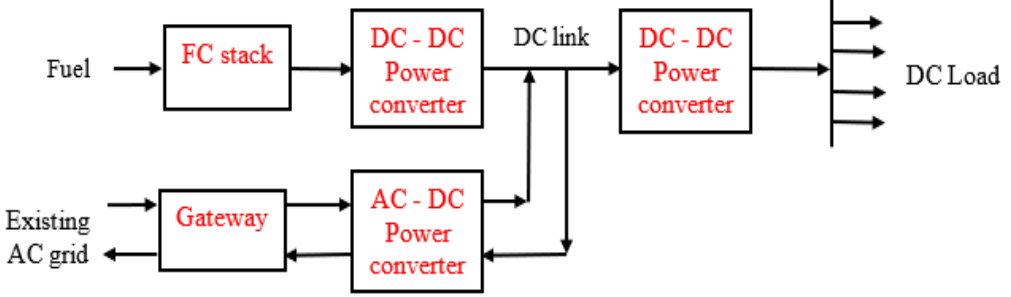
Figure 8. Schematic of a DC microgrid based on FC.